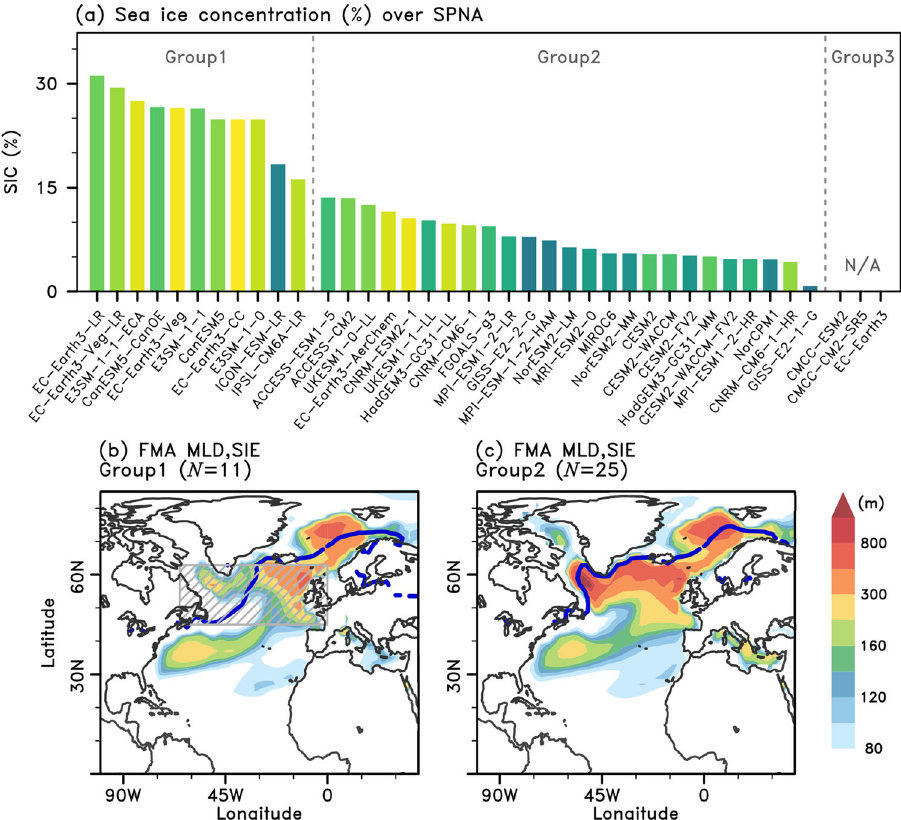
Fig. 2 FMA-mean characteristics in the SPNA and the North Atlantic. a Sea ice concentration (SIC; unit: %) averaged over the SPNA region (hatched area in b ) for each model where color code for individual models follows that of Fig. 1a. Models are arranged by descending order of the SPNA-averaged SIC. Gray vertical line divides each group. For three models in Group 3, the SIC variable was not available (N/A). b , c Ensemble mean of FMA-mean mixed layer depth (shaded; unit: m) and SIE outline (dark blue line) for each group. The number of models used for each group is shown as N . Here, SIE was de fi ned as the boundary of the region where the sea ice concentration is maintained larger than 15%. Individual model results are shown in Supplementary Fig.